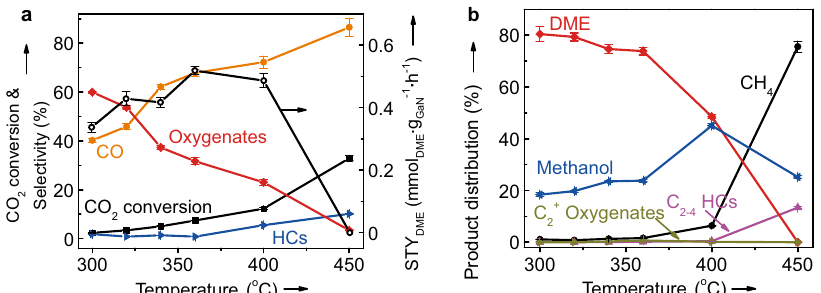
Fig. 1 Catalytic performance of the commercial GaN for the hydrogenation of CO 2 at different temperatures. a The CO 2 conversion, the selectivity of different products and the space-time yield of DME (STY DME ). b Detailed CO-free distribution of hydrocarbons (HCs) and oxygenates. Reaction conditions: P = 2.0 MPa, H = 3, gas hourly space velocity = 3000 mL g − 1 h − 1 , and time on stream = 40 h. The error bar representing the relative deviation is 2 /CO 2 within